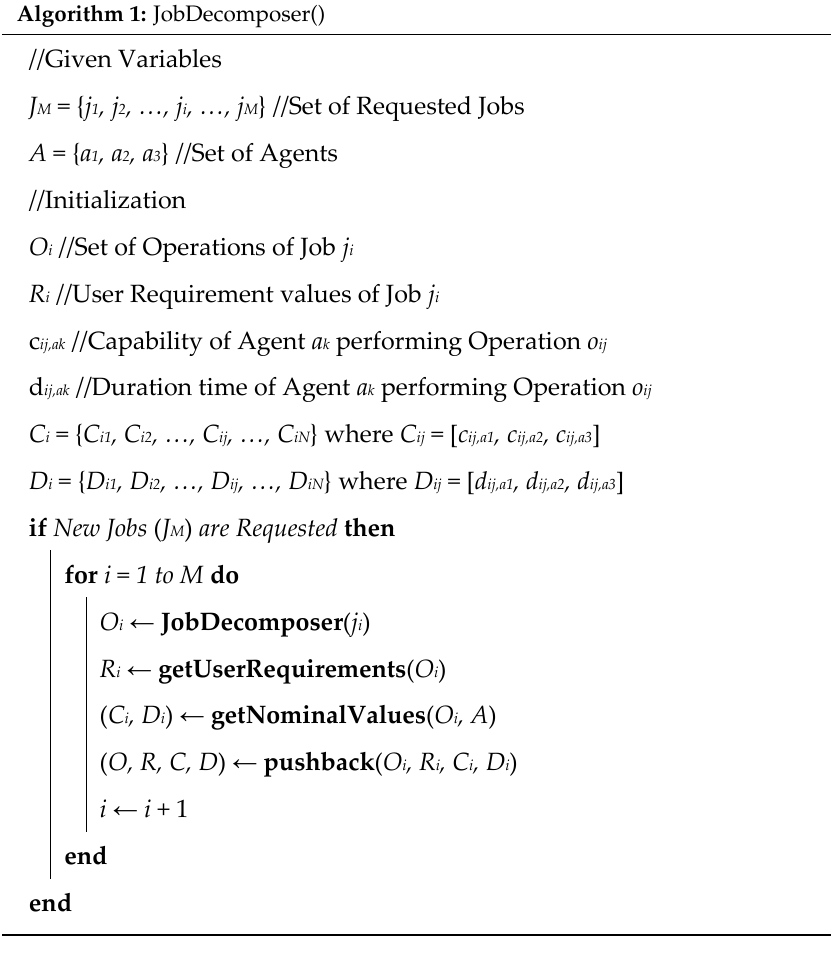
Table 1. Example of an operation list.